Question: According to the figure, is the described quantity increasing or decreasing?
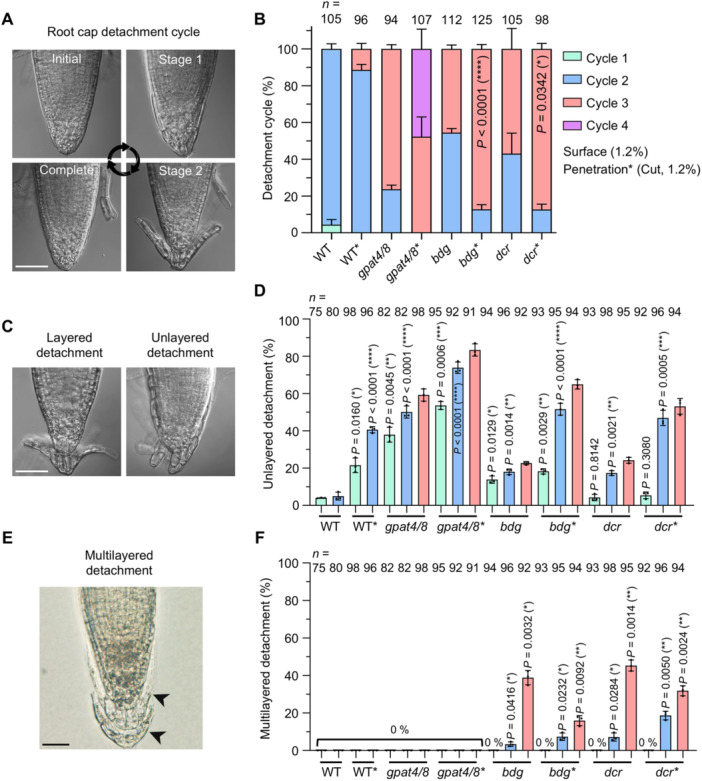
Answer: increasing